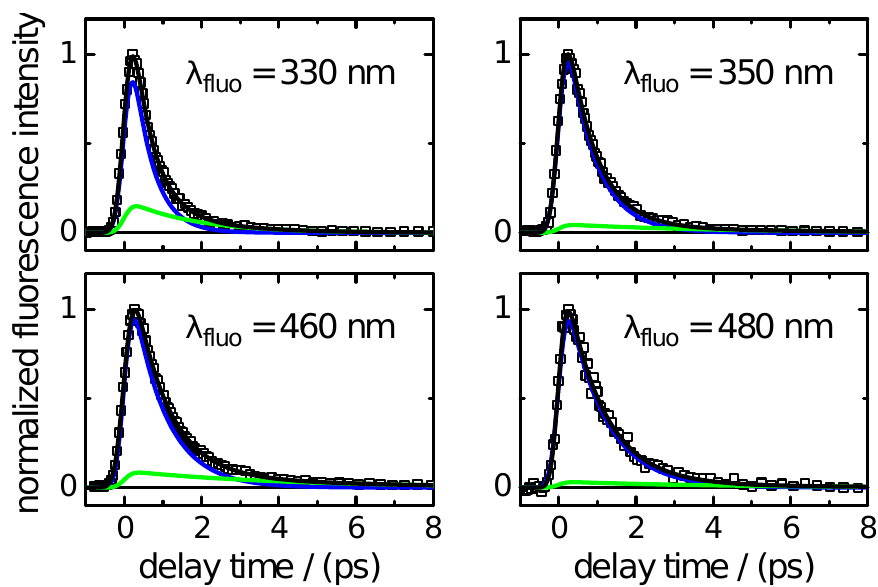
Figure 7. Fluorescence time profiles of XMP − after excitation at λ pump = 260 nm measured at four selected emission wavelengths in the range λ fluo = 330–480 nm. Open squares represent data points, black lines the overall fit functions. The single contributions are shown in blue ( τ 1,fluo ) and green ( τ 2,fluo